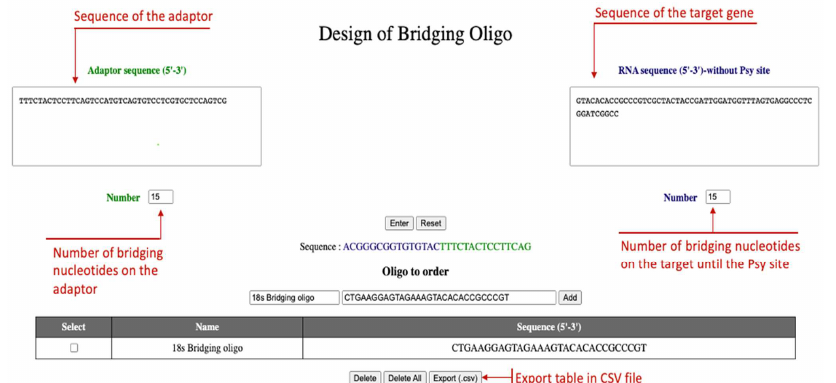
Figure 2. Use of DBO tool. The adaptor sequence is on the left box, the 18S RNA on the right box. The sequence of the 18S RNA started just after the Psi site to be tested. Pressing “Enter” will provide the intermediary hybrid oligo (before transformation) and the “Oligo to order” will give the oligo as it has to be ordered. By clicking the “Add” button, oligos are added to a list that is exportable to a CSV file to ease the ordering.